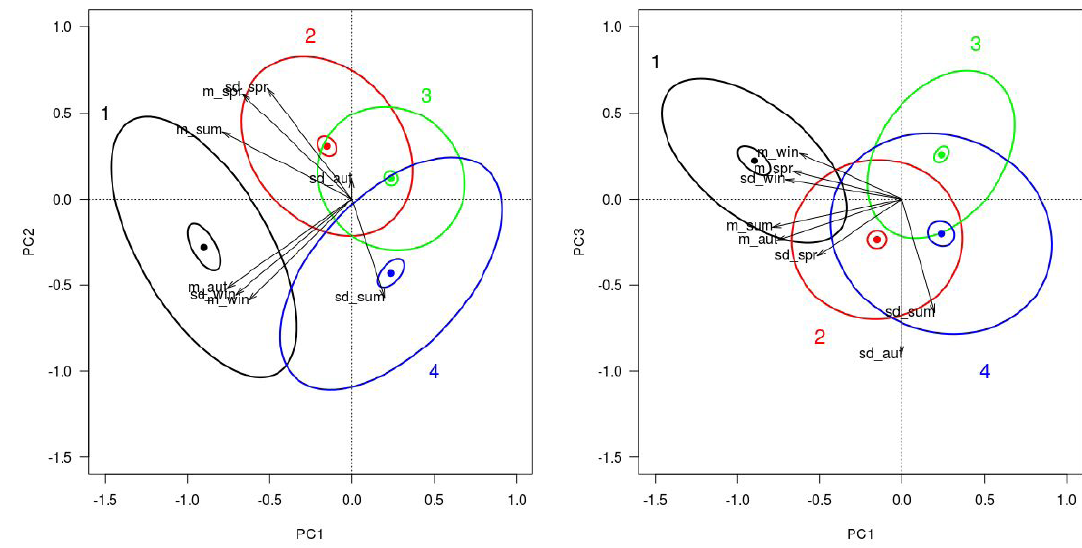
Figure 1. Biplot of the first two principal components PC1 and PC2 (a) and first and third principal components PC1 and PC3, with 95% confidence ellipses for prediction (larger diameter) and mean vector (smaller diameter) of each group considering 60mm soil holding capacity. As results for different soil water holding capacities were very similar, only results from 60 mm soil water holding capacities are